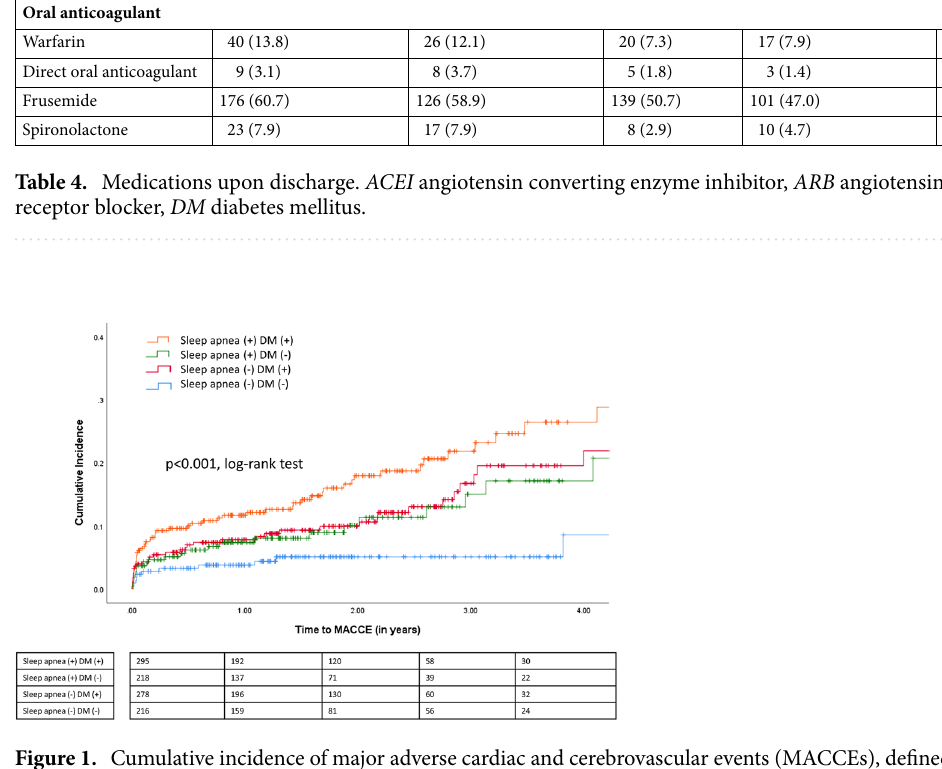
Table 4. Most of the patients were using aspirin, β blockers, and statins at discharge. Patients in both sleep apnea (+) groups were more likely to use frusemide, spironolactone, and warfarin than were those in both sleep apnea (−) groups, regardless of the DM status.